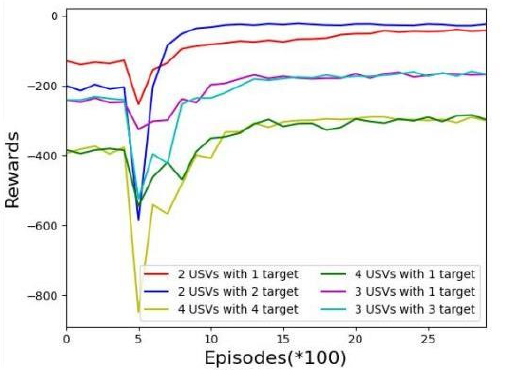
Figure 6. Rewards versus episodes for the different numbers of USVs under the MADDPG algo-